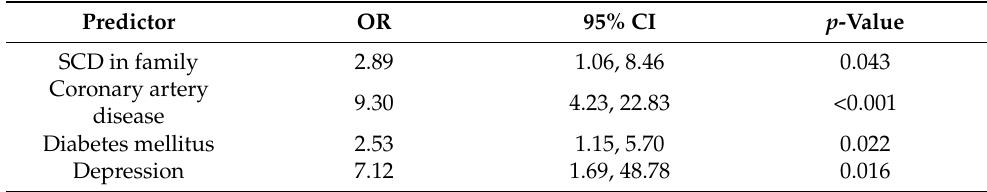
Table 2. Odds of being a primary preventive (PP) patient with an ICD versus being in the control group without an ICD. Results of a final multivariate logistic regression model after stepwise exclusion of insignificant